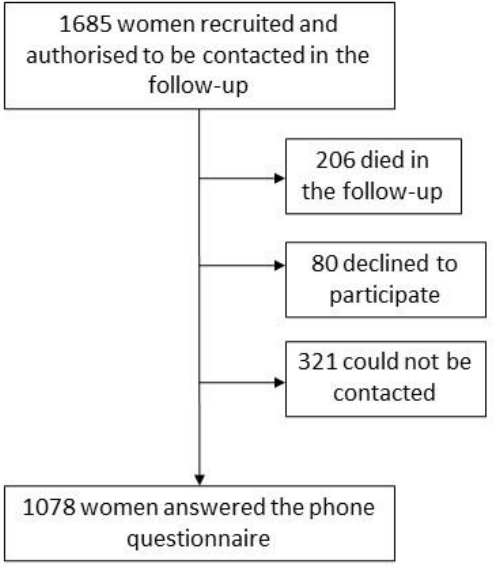
Figure 1. Study Figure 1. Study flow-chart.